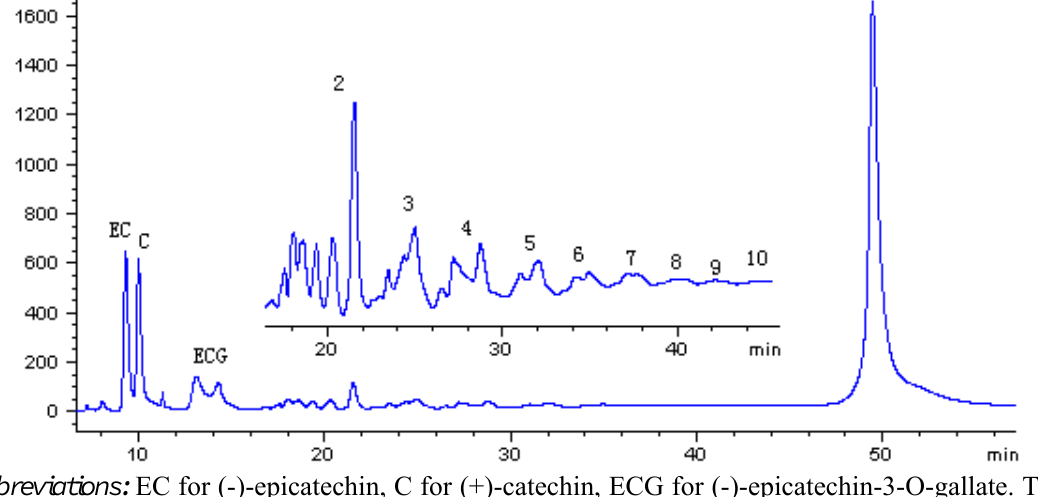
Abbreviations: EC for (-)-epicatechin, C for (+)-catechin, ECG for (-)-epicatechin-3-O-gallate. The inset shows the peaks between retention time 20 to 46 min, marked with the numbers 2-10. The numbers represents the DP of